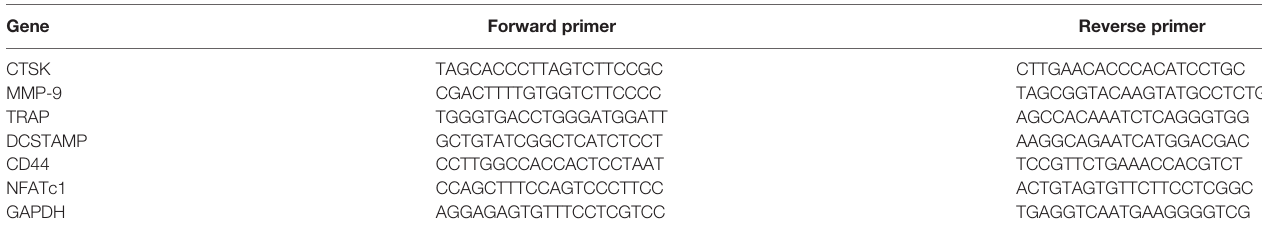
TABLE 1 | Sequences of the primers used in this study. Gene Forward primer Reverse